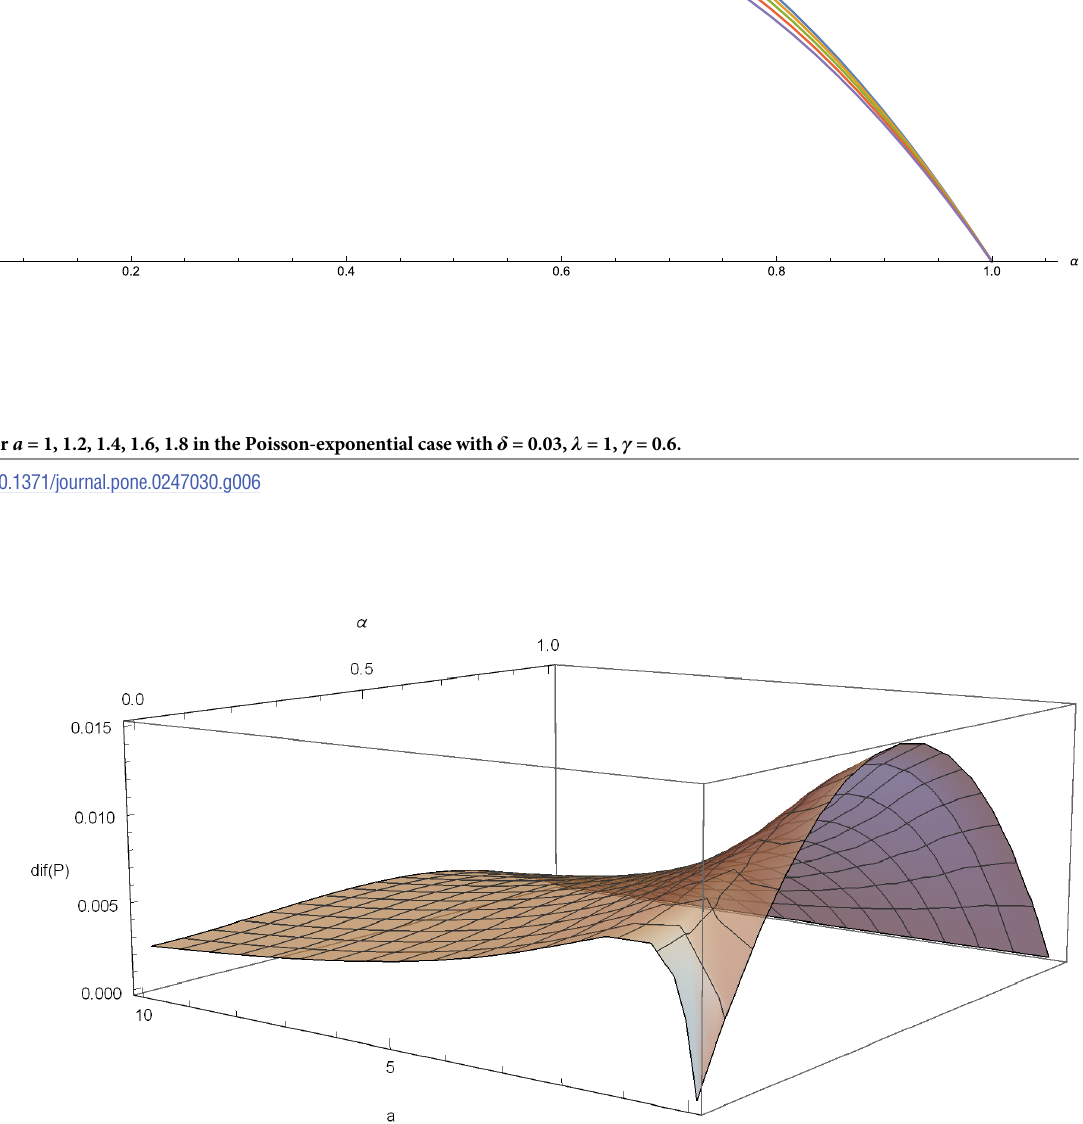
PLOS ONE | https://doi.org/10.1371/journal.pone.0247030 February 17,